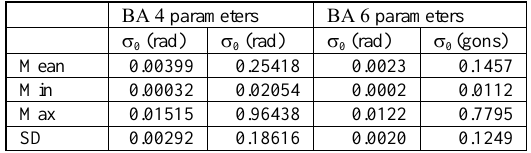
Table 1. Average standard deviation for bundle adjustment at 4 and 6 parameters.